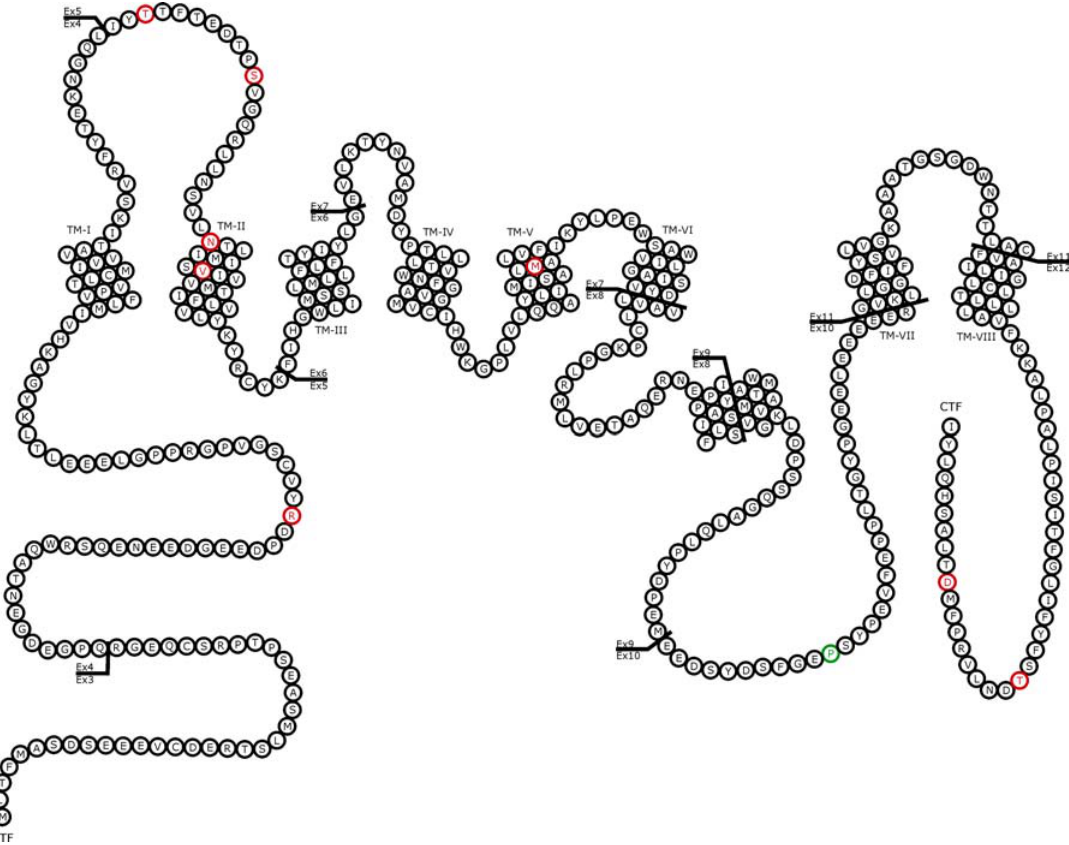
FIGURE 4. Schematic representation of PSEN2. Amino acids with pathogenic missense mutations are shown in red and amino acids with not-pathogenic missense mutations are in green. For each mutation a hyperlink to the AD mutation database (http://molgen- www.uia.ac.be/ADMutations/) is